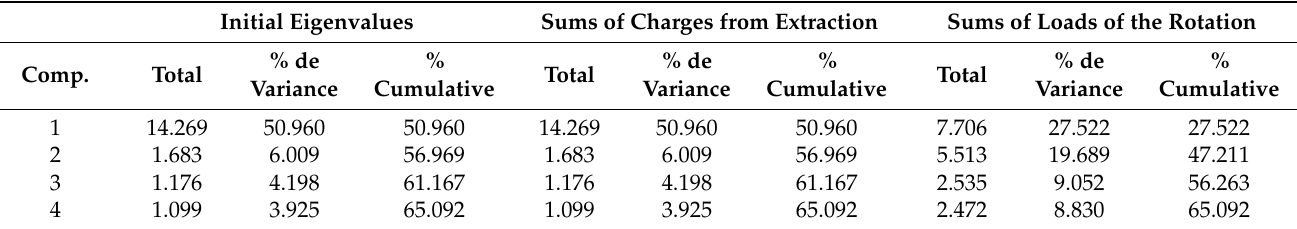
Table 6. Factor extraction of ethical values in leadership.